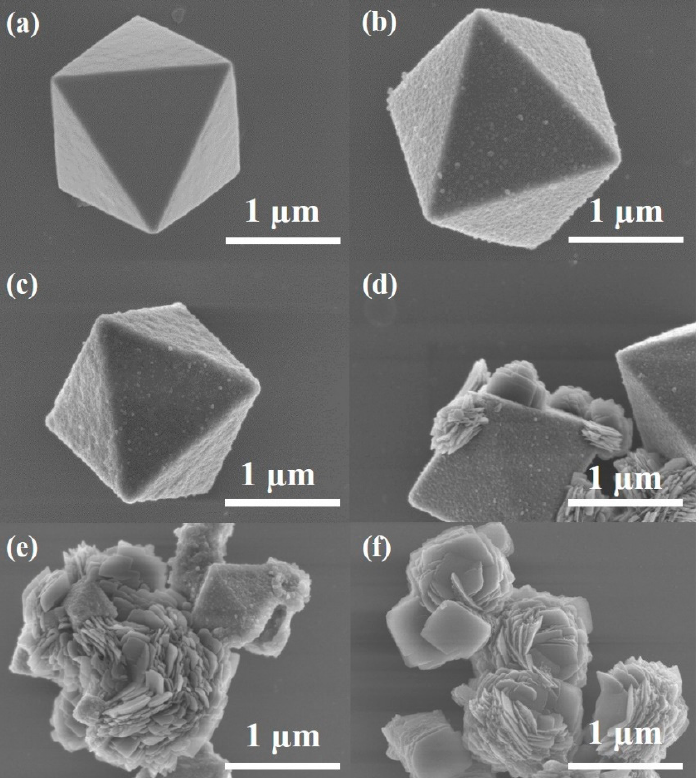
Figure 1. SEM images of ( a ) Cu 2 O, ( b ) Cu 2 O@Cu-BDC-NH 2 -4h, ( c ) Cu 2 O@Cu-BDC-NH 2 -8h, ( d ) Cu 2 O@Cu-BDC-NH 2 -12h, ( e ) Cu 2 O@Cu-BDC-NH 2 -20h, and ( f ) Cu 2 O@Cu-BDC-NH 2 -32h.